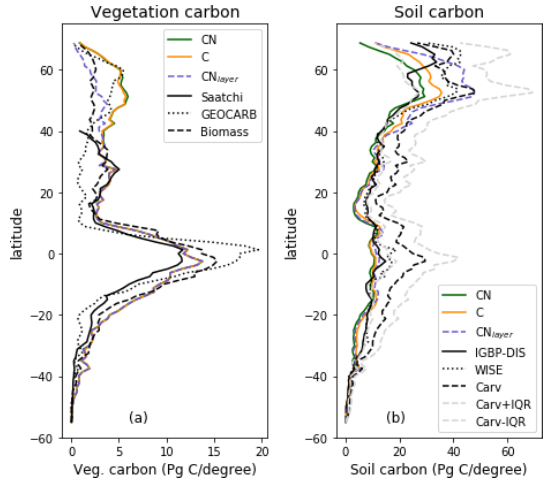
Figure 6. Zonal total values of (a) vegetation and (b) soil C for JULES-C, JULES-CN, and JULES-CN layer simulations for the pe- riod 1996–2005 in PgC(degree latitude) − 1 . For the vegetation C the observation-based constraints are Saatchi: Saatchi et al. (2011); GEOCARB: Avitabile et al. (2016); and biomass: Ruesch and Gibb (2008). The observation-based constraints for the soil carbon are IGBP-DIS: Global Soil Data Task Group (2000); WISE: Batjes (2016); and Carvahlais: Carvalhais et al. (2014).